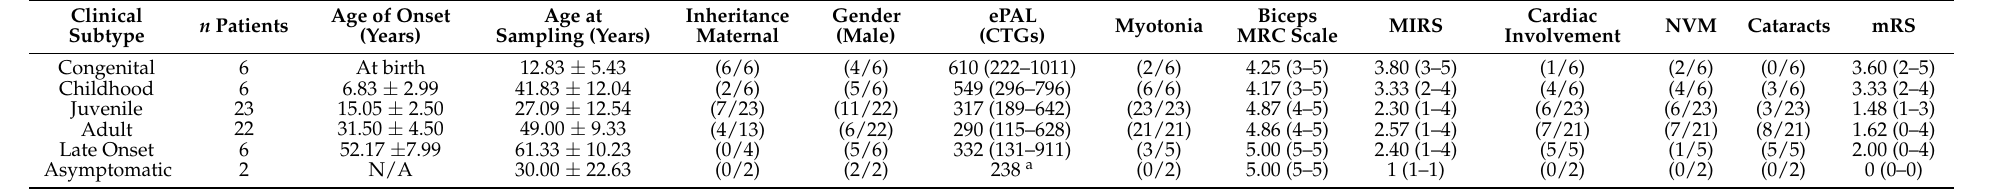
Table 2. Clinical characteristics cohort.